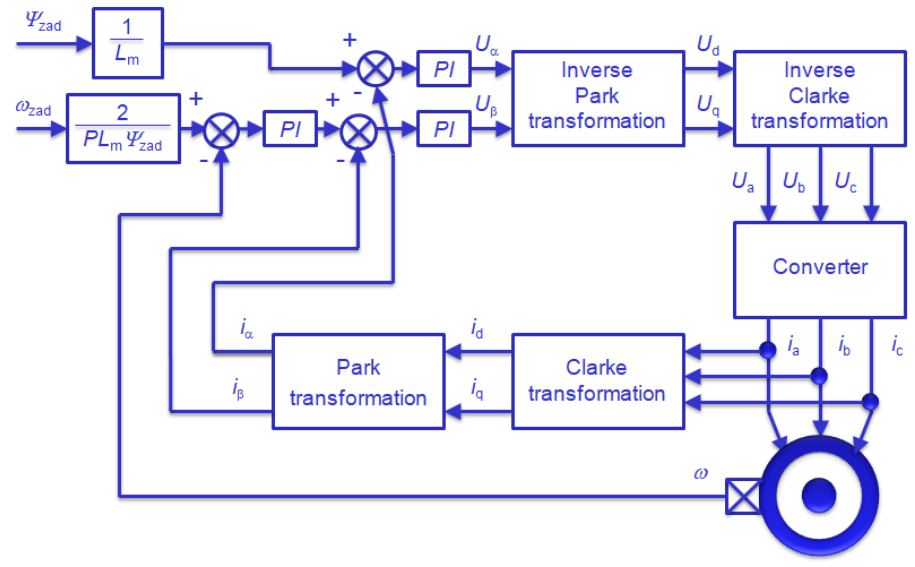
Figure 12. Block diagram of the Field Oriented Control (FOC).